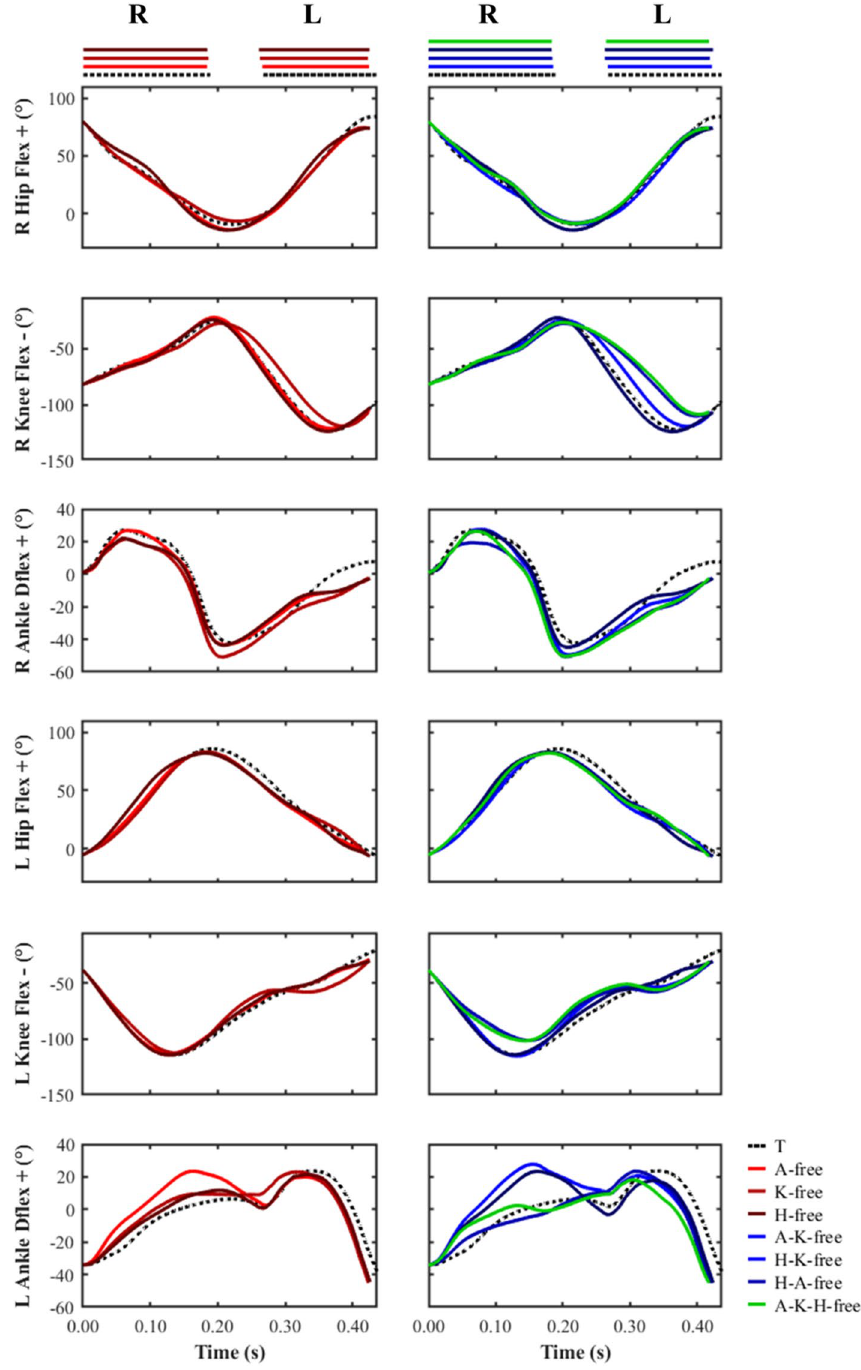
Figure 8. Right and left ankle dorsiflexion-plantarflexion angles, and knee and hip flexion–extension angles from right foot touchdown to left foot take-off for the data-tracking (T) and predictive simulations (A-free, K-free, H-free, A-K-free, H-K-free, H-A-free, A-K-H-free). The horizontal bars at the top of the figure indicate periods of right (R) and left (L) stance. The outputs from the simulations were not plotted on the same set of axes to avoid interpretability and visualisation